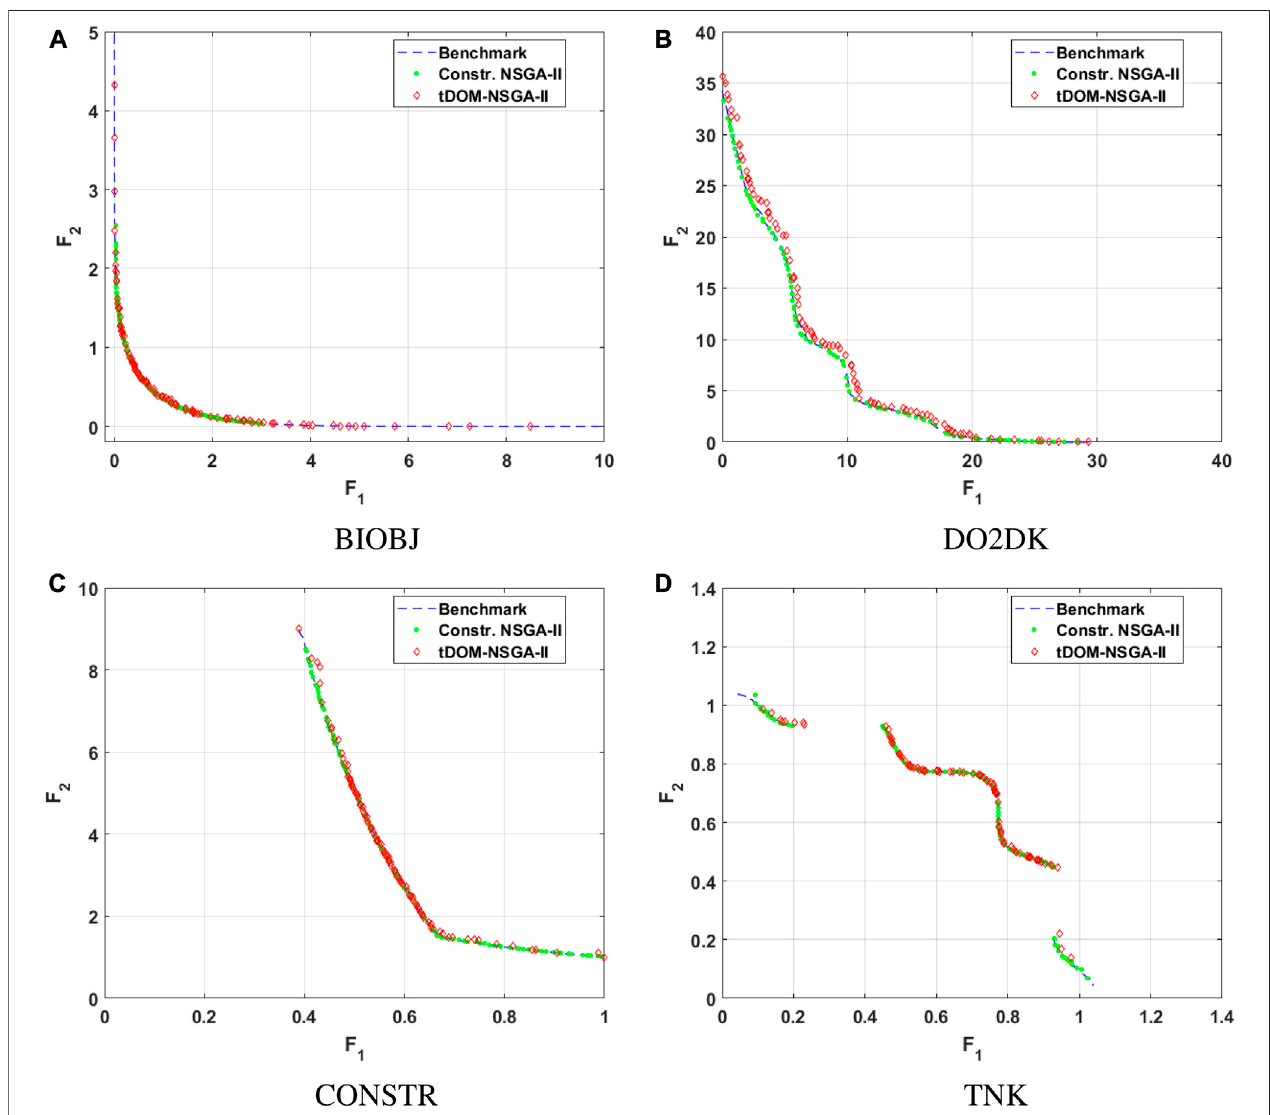
FIGURE 5 | Pareto front of the biobjective problems generated via tDOM-NSGA-II.